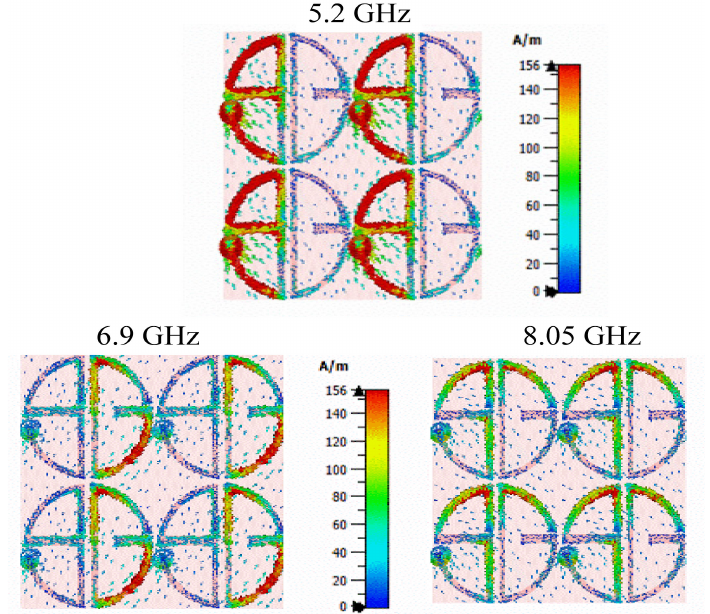
Figure 10. Simulated Surface current distribution at 5.2, 6.9, and 8.05 GHz.